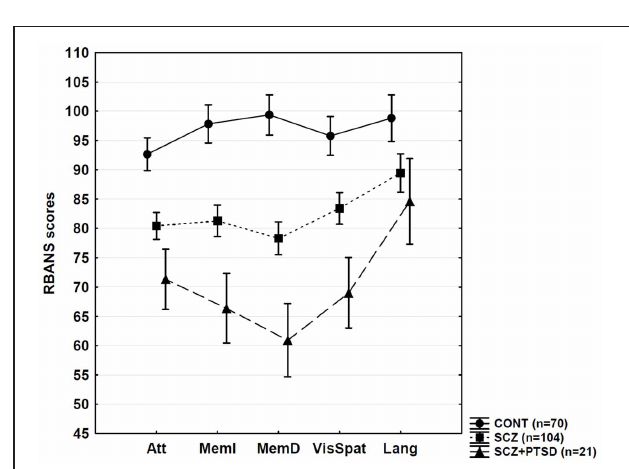
FIGURE 3 | Neuropsychological results. CONT, control; SCZ, schizophrenia; PTSD, posttraumatic stress disorder; RBANS, Repeatable Battery for the Assessment of Neuropsychological Status; Att, attention; MemI, immediate memory; MemD, delayed memory; VisSpat, visuospatial; Lang, language. Error bars indicate 95% confidence intervals. For statistical details, see Table 2